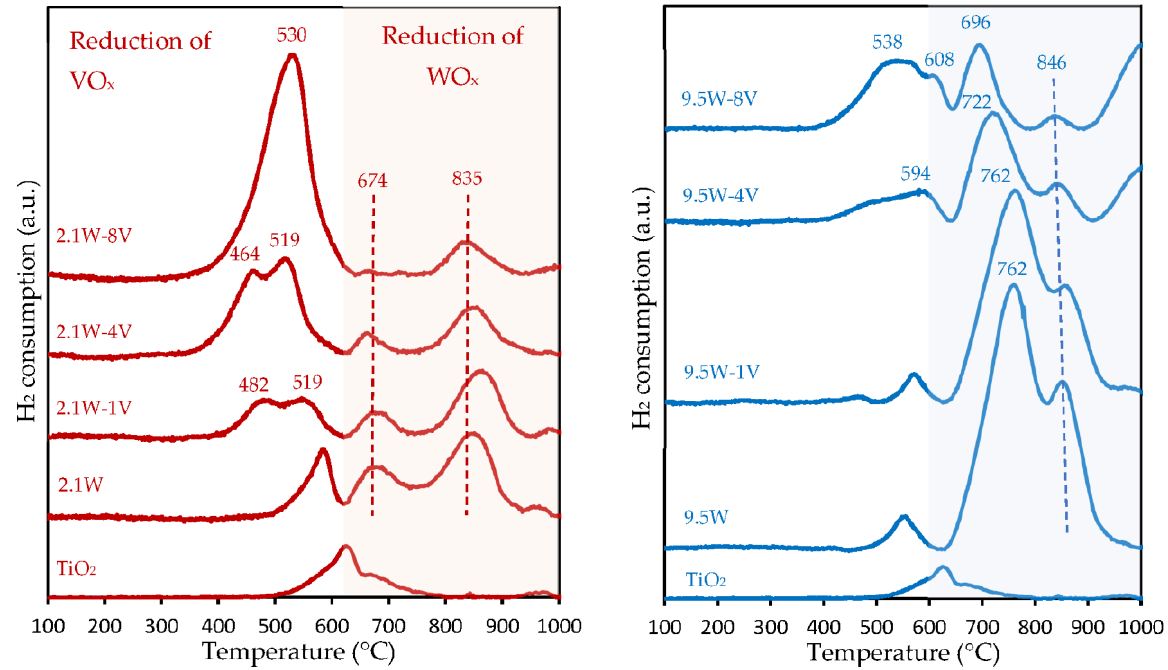
Figure 8. H 2 -consumption profiles vs. temperature from H 2 -TPR experiments for calcined V 2 O 5 - WO 3 /TiO 2 SCR-catalysts.